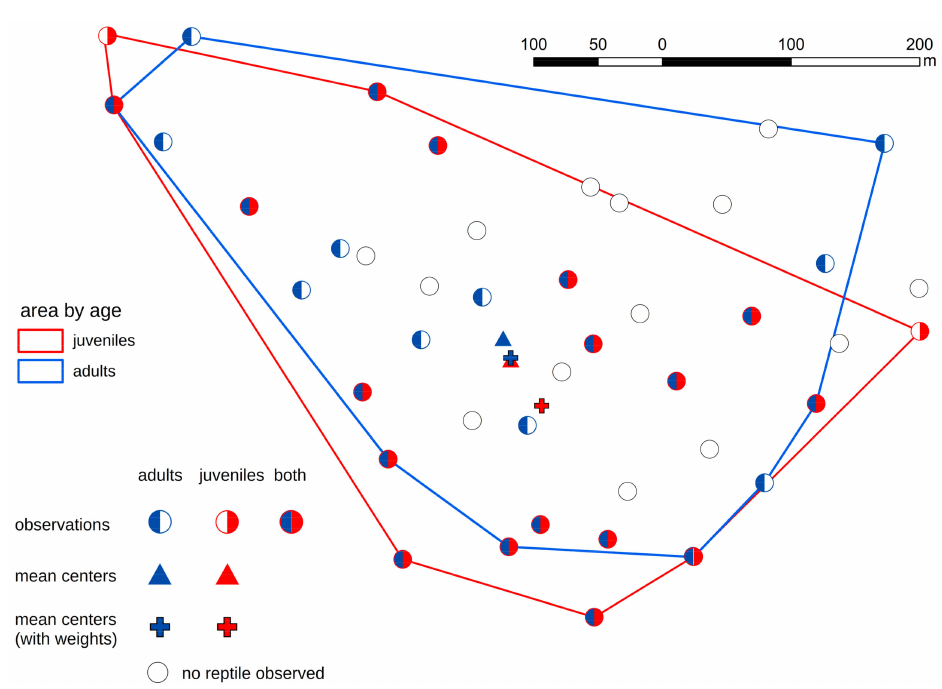
Figure 4. Slow worms’